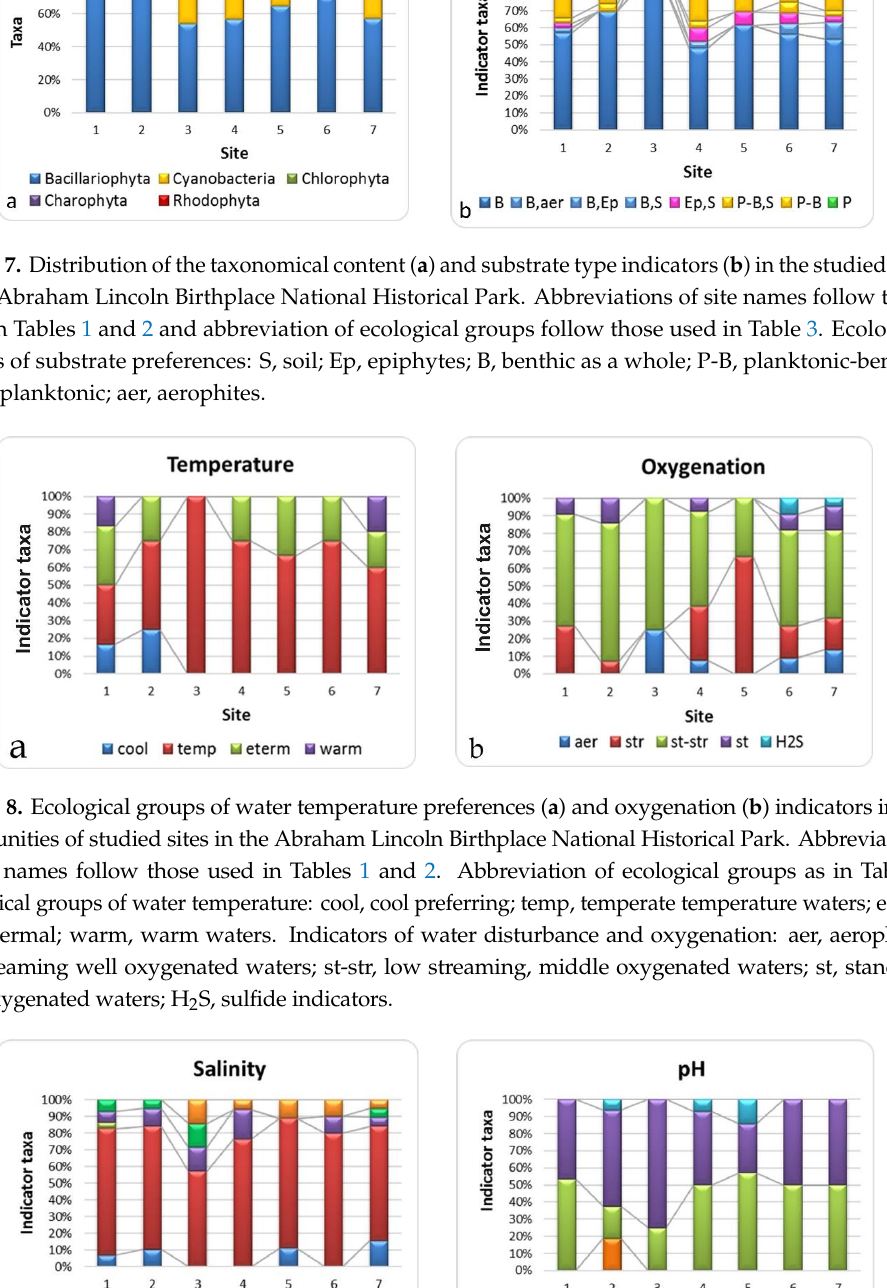
Figure 7. Distribution of the taxonomical content ( a ) and substrate type indicators ( b ) in the studied